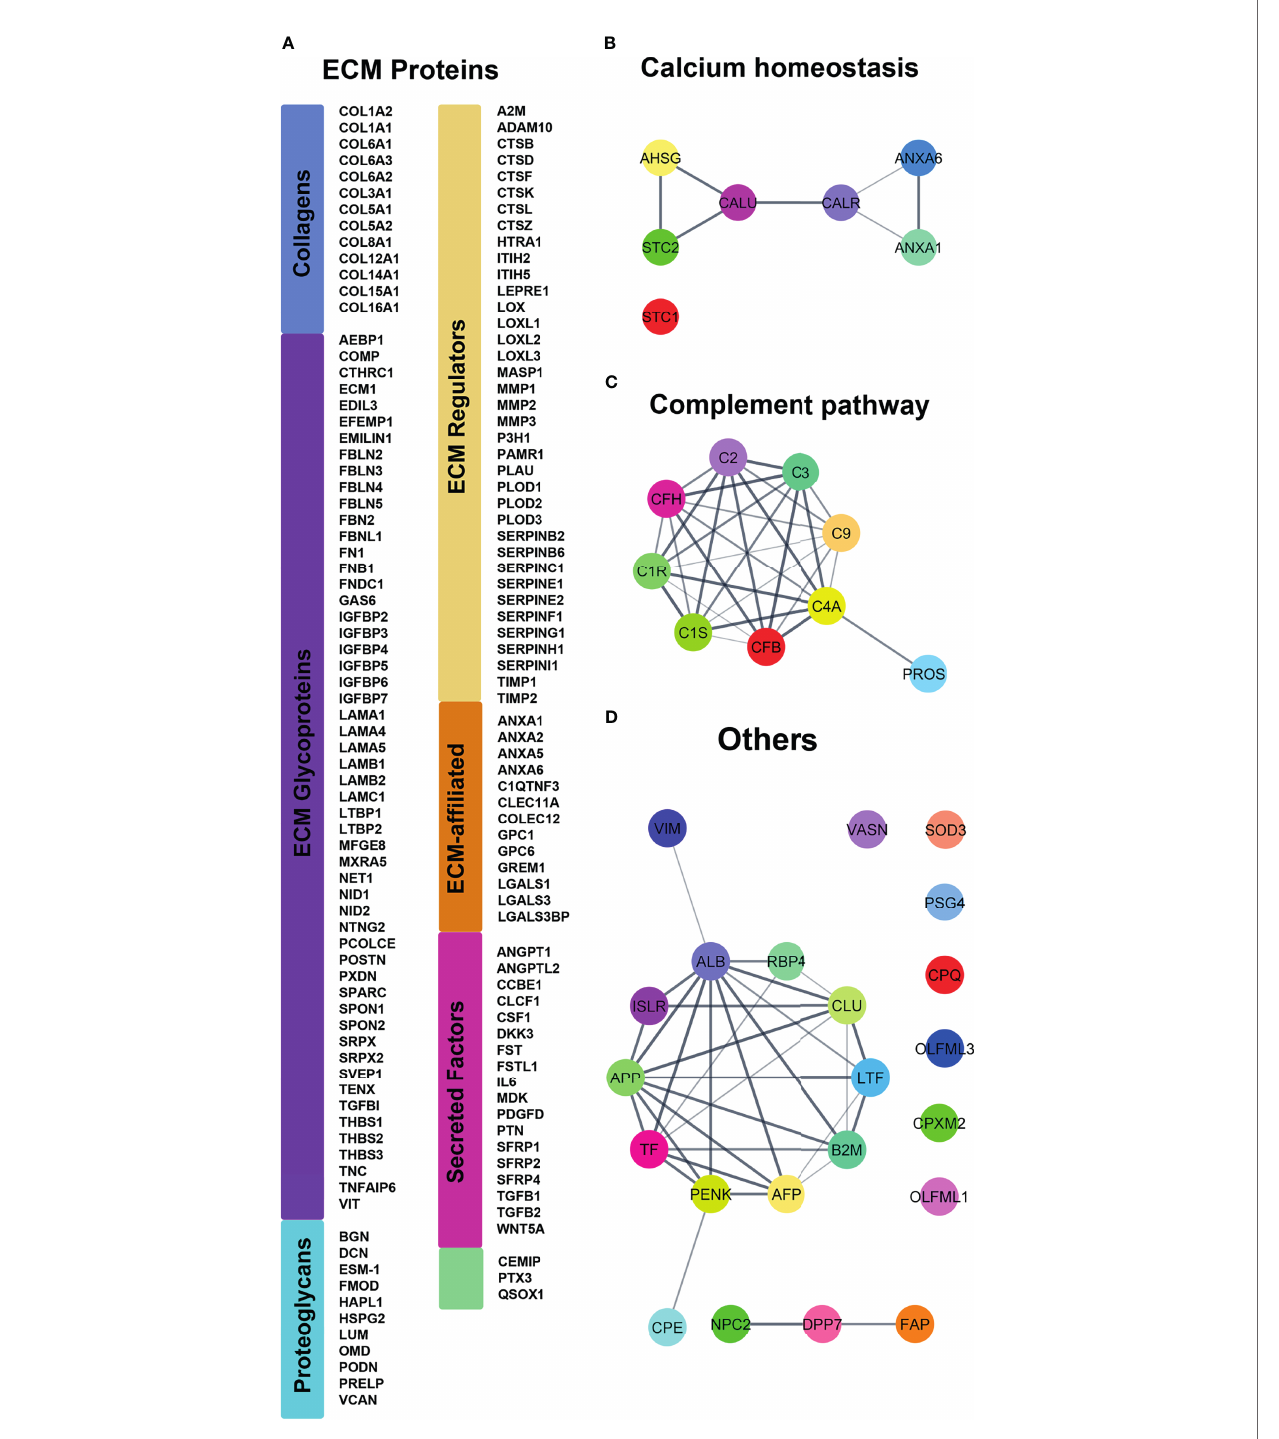
FIGURE 1 | Proteomic analysis of the classically secreted proteins identi fi ed in controls and ERS patients secretomes using MS. (A) Classi fi cation following Naba et al. (29) of the 140 ECM proteins. Proteins are represented by their corresponding gene name (HUGO Gene Nomenclature) for clarity. (B – D) String analyses revealed supplementary interactomes of (B) calcium interacting proteins, (C) complement cascade and (D) remaining classically secreted